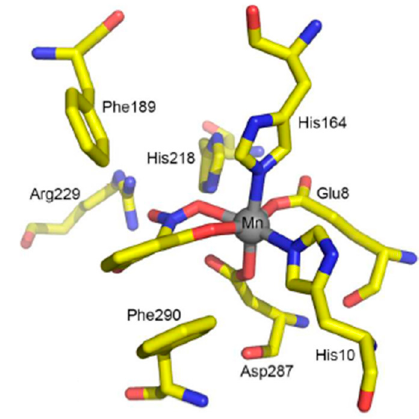
Figure 12. Active site structure of γ -RSD from Polaromonas sporomusa JS6666 (coordinating the 2-nitroresocinol inhibitor) showing the Mn 2+ cation coordinated in an octahedral geometry. Reprinted with permission from [54]. Copyright 2018, American Chemical Society.